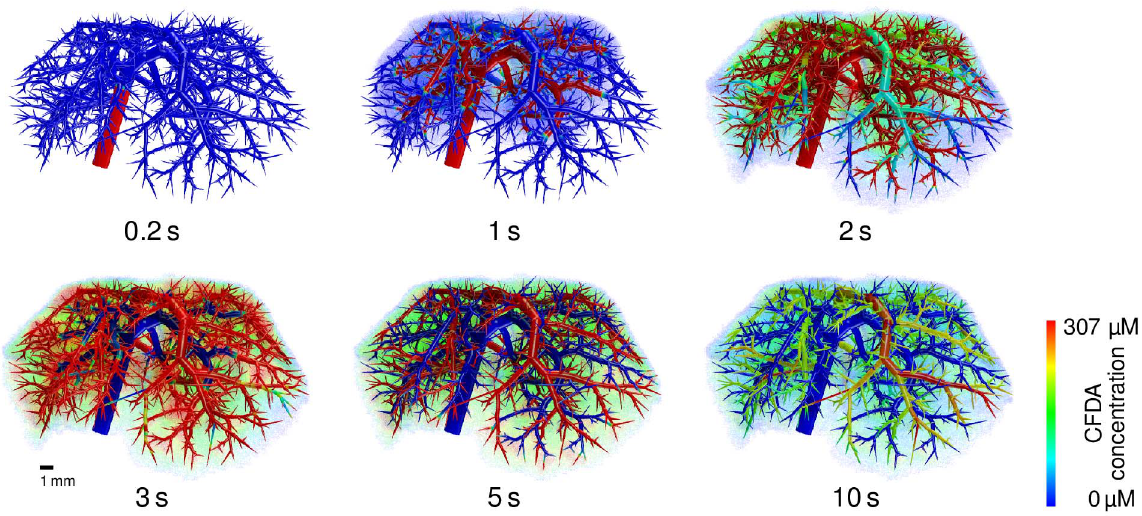
Figure 7. Results of the spatio-temporal perfusion simulations of CFDA SE in the liver. The volume renderings show the distribution of CFDA SE in the mouse liver for the healthy state at different time points, showing the first pass of perfusion ( t ƒ 2s ), the distribution phase ( 1s ƒ t ƒ 5s ) and the wash out ( t § 3s ).